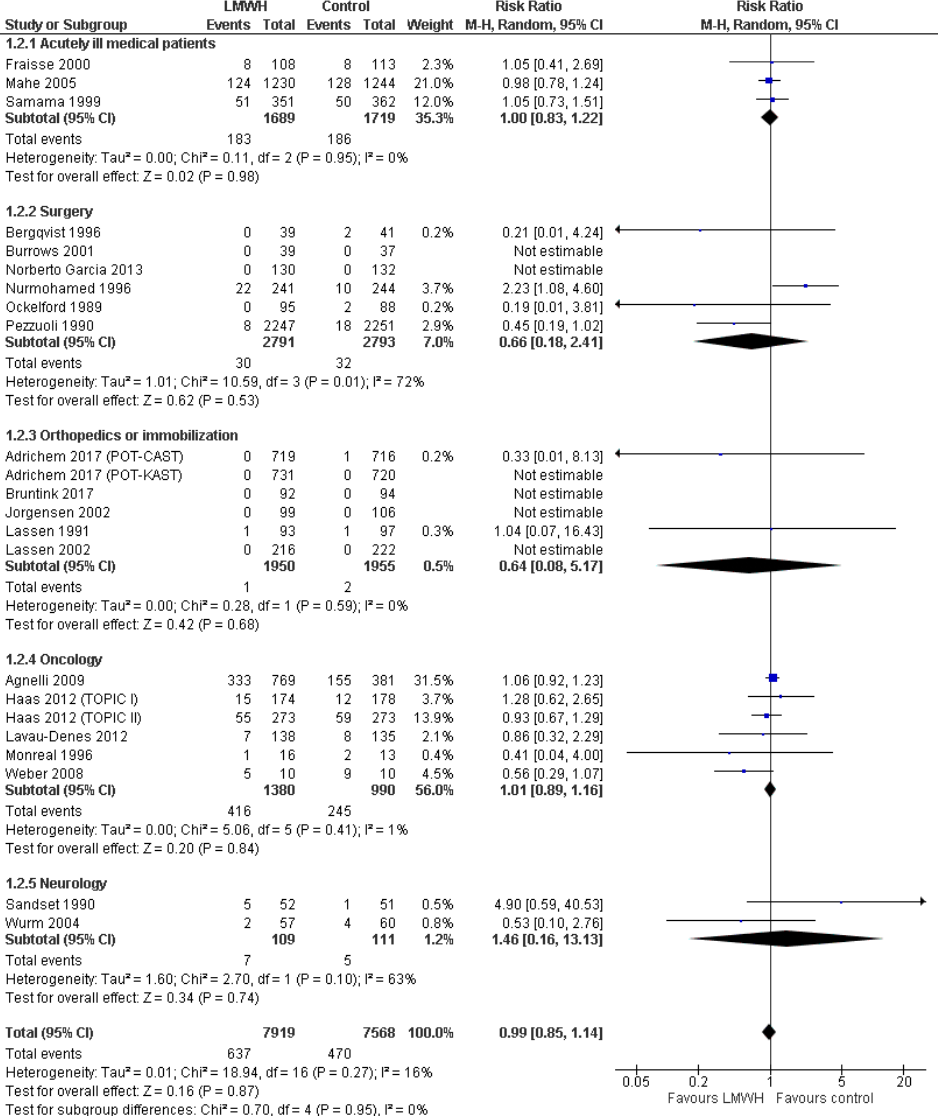
Figure 2. Forest plot of all-cause mortality. Forest plot of all-cause mortality at maximal follow-up of LMWH prophylaxis compared to placebo or no treatment, stratified according to population. The size of the squares reflects the weight of the trial in the pooled analysis. Horizontal bars represent 95% confidence intervals; LMWH, low-molecular-weight heparin; CI, confidence intervals.